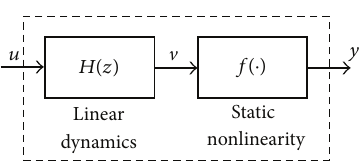
Figure 1: Wiener type model configuration.